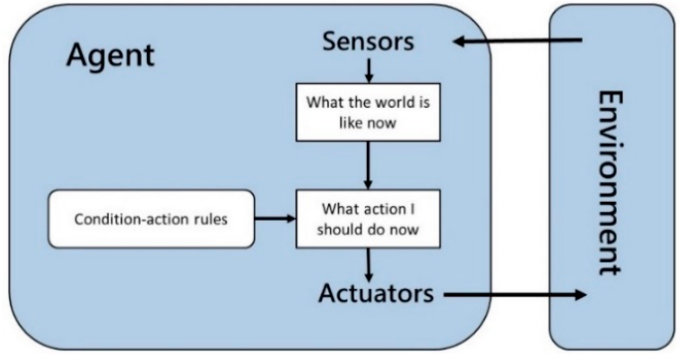
Figure 2. A simple reflex agent-operating model.